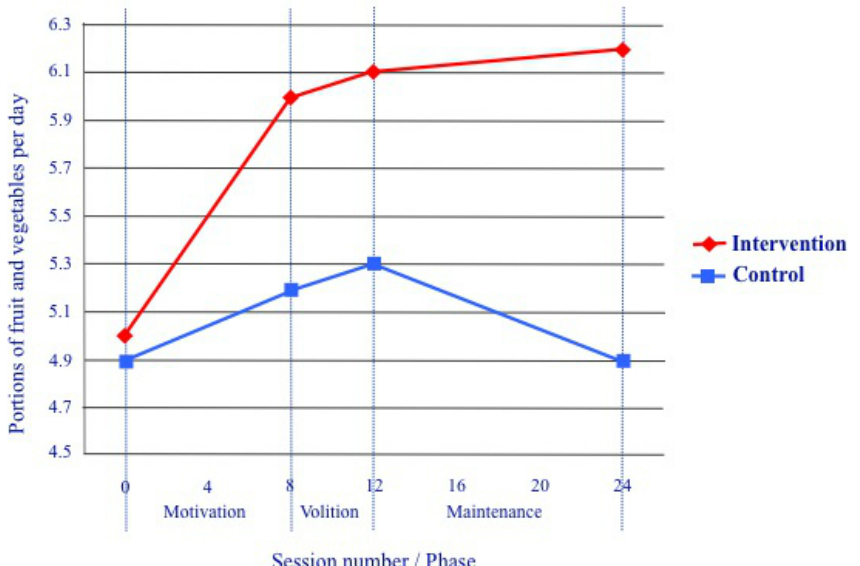
Figure 2. Portions of fruit and vegetables consumed in the intervention and control groups at the start and end of each program